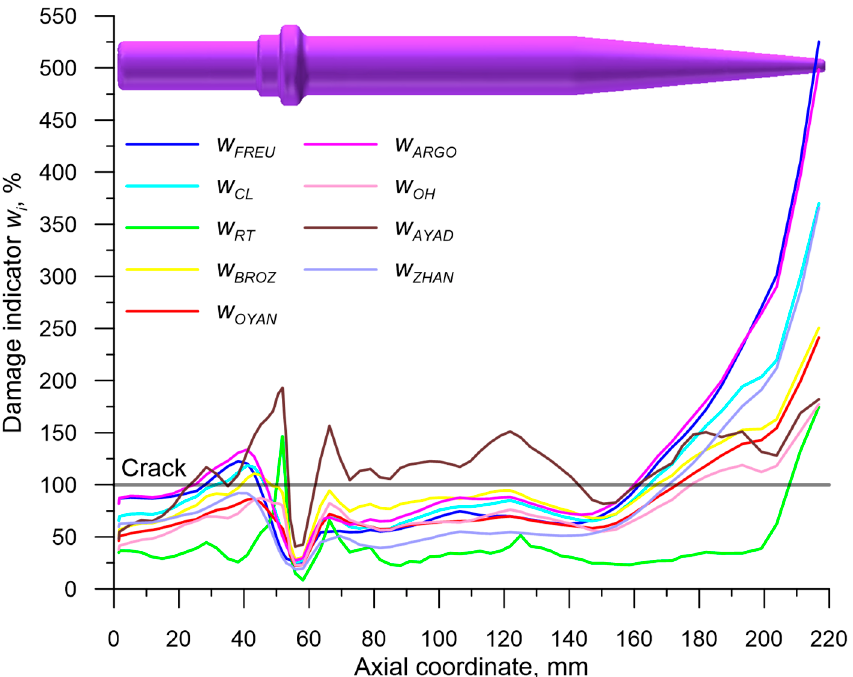
Figure 19. Characteristics of the stress state in the axis of the rolled part expressed by the averaged values of stress triaxiality and the Lode angle parameter.